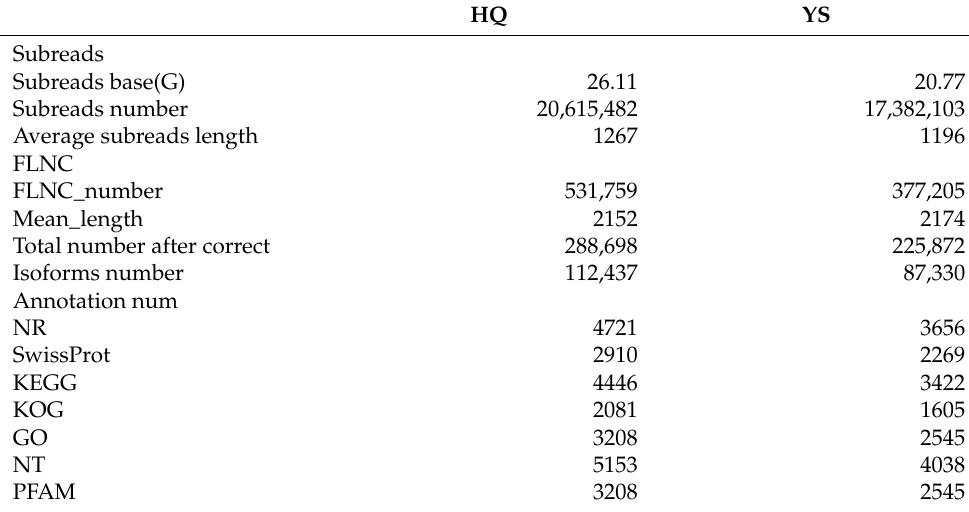
Table 1. The overview of full-length